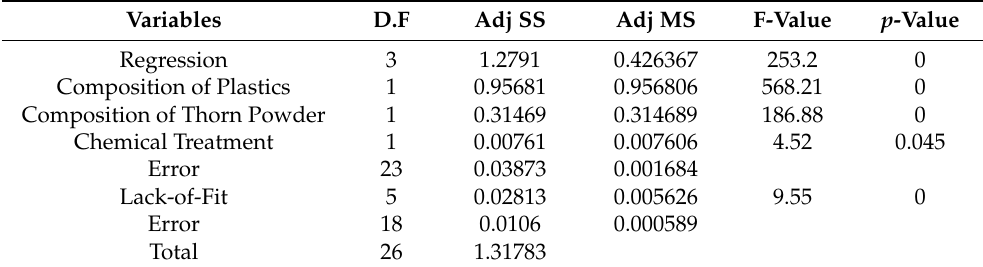
Figure 8. Contribution plot for water absorption.